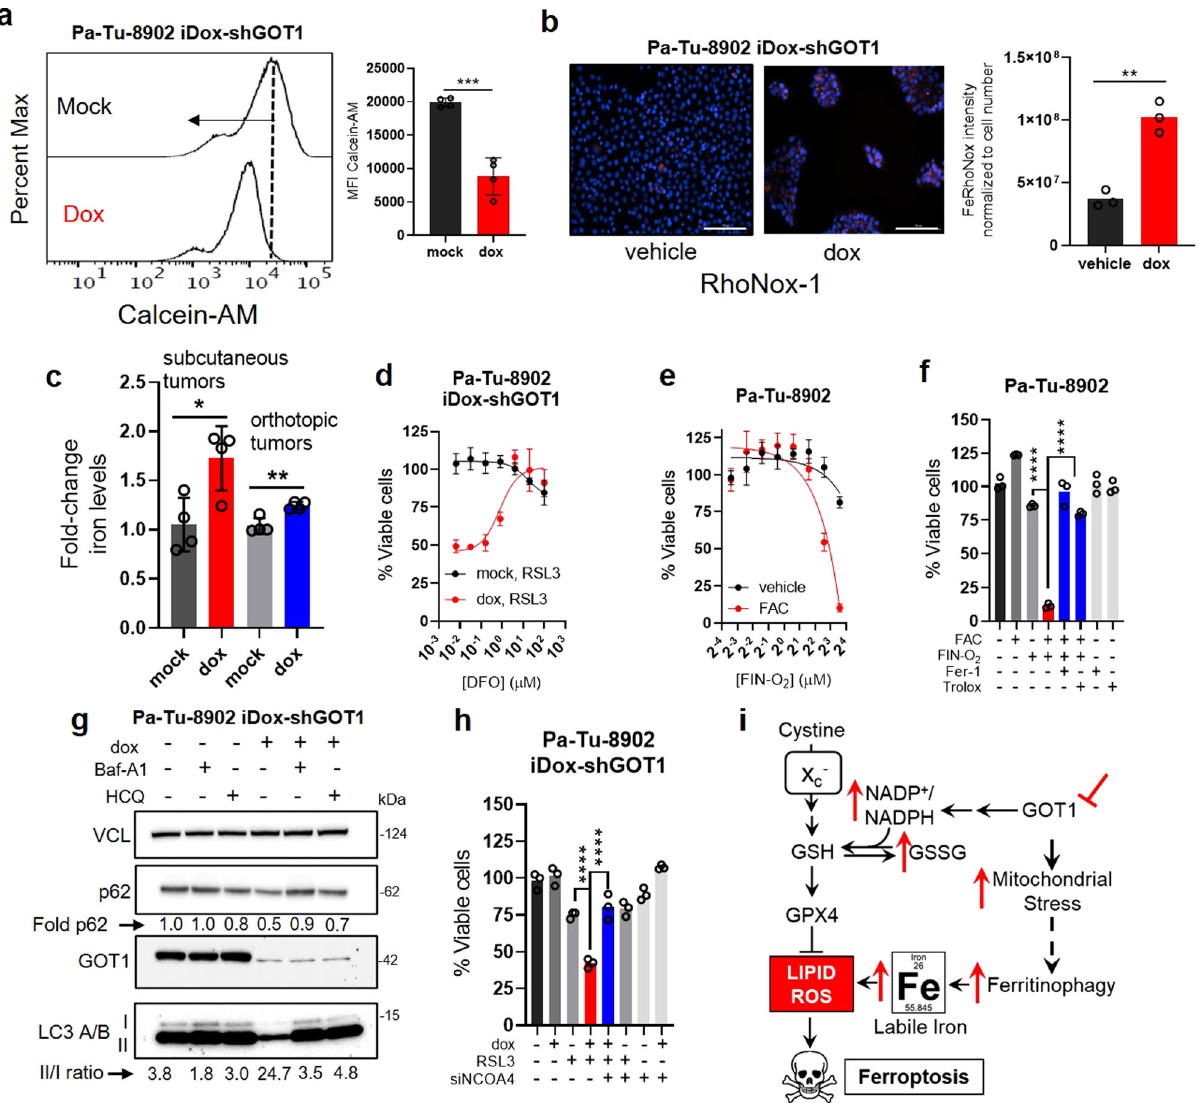
Fig. 5 GOT1 inhibition promotes labile iron release. a Calcein-AM histogram ( a ) and mean fl uorescence intensity (MFI) (*** P = 0.0002) upon 5 days of GOT1 knockdown, n = 3 biological replicates. b Visualization and quanti fi cation of GOT1 knockdown cells treated with the iron probe RhoNox-1, n = 3 biological replicates. ** P = 0.0013. Scale bars represent 200 μ m. Image is representative of two independent experiments. c ICP-MS (Inductively coupled plasma mass spectrometry) measurements of iron in subcutaneous and orthotopic tumors following GOT1 knockdown, n = 4 tumors, * P = 0.0191 and ** P = 0.0036. d Cell viability normalized to vehicle of cells co-treated with 32 nM RSL3 and increasing doses of DFO, n = 2 biological replicates. e Cell viability dose response to FINO 2 with or without 200 µ M ferric ammonium citrate (FAC), n = 3 biological replicates. Cell viability of FINO 2 with 200 µ M FAC (ferric ammonium citrate) ( f ) or the indicated rescue conditions n = 3 biological replicates, **** P = < 0.0001. g Western of autophagy markers following GOT1 knockdown representative of two independent experiments. h Cell viability in cells co-treated with RSL3 and siNCOA4 following GOT1 knockdown, n = 3 biological replicates, **** P ≤ 0.0001. i Model describing the GOT1-mediated potentiation of ferroptosis through ferritinophagic iron release. Error bars represent mean ± SD. Two-tailed unpaired T -test or one-way ANOVA. Source data are provided as a Source Data fi